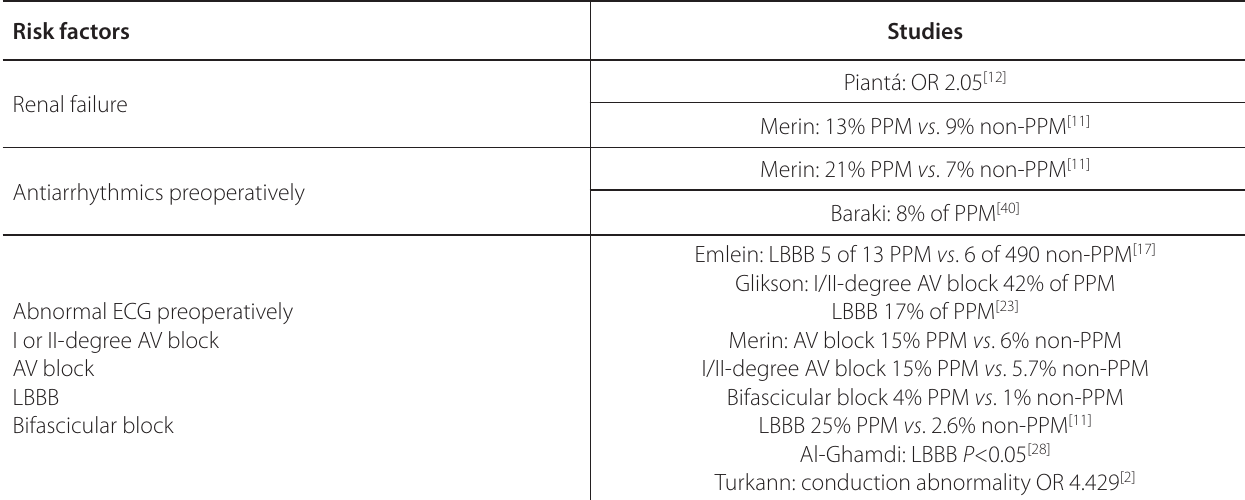
Table 2 . List of risk factors for greater incidence of PPM postoperatively. Risk